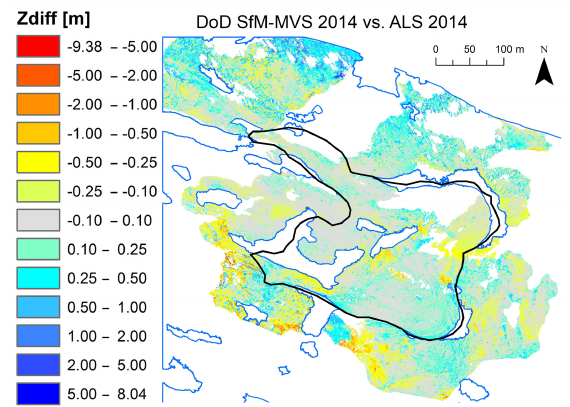
Figure 14. Spatial distribution of elevation differences between photogrammetric and ALS-based DEM acquired on 27 September and 24 September 2014, respectively. The blue outline is the snow accumulation areas which were excluded during the DEM compar-